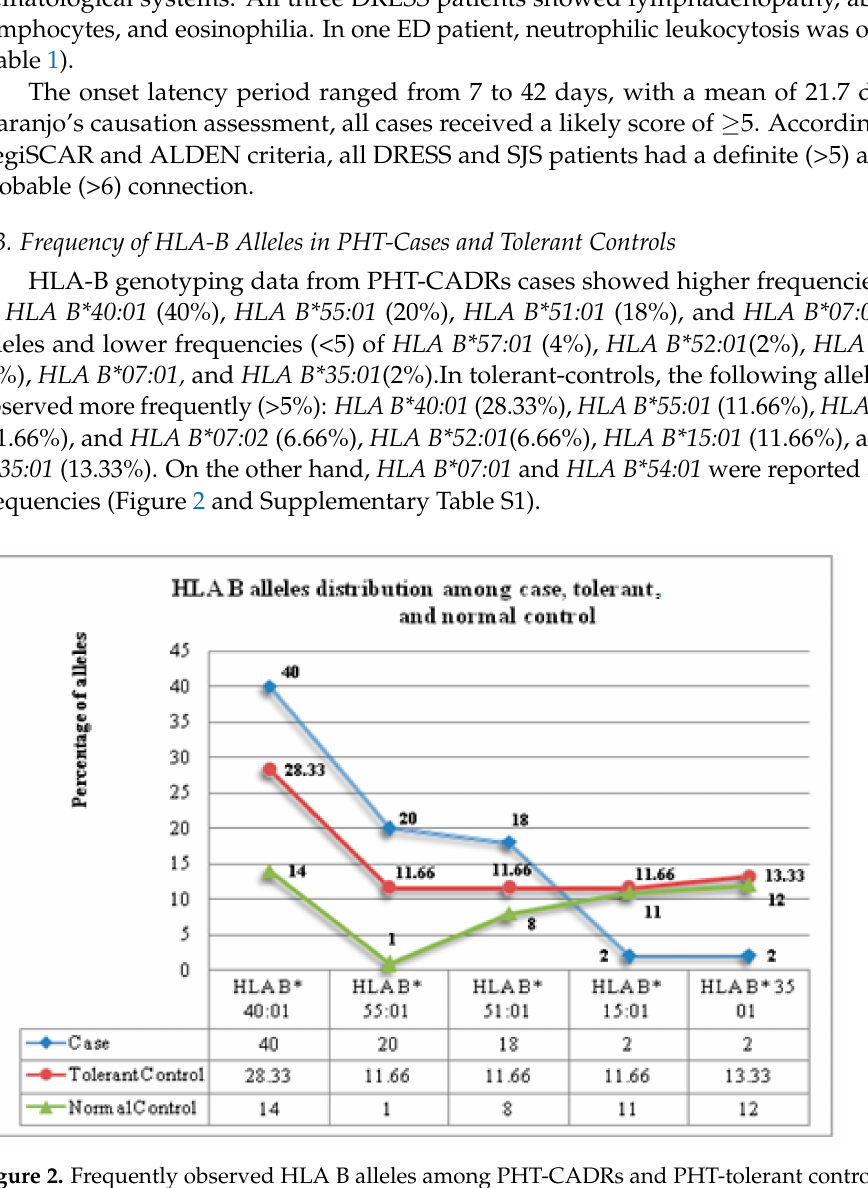
Figure 2. Frequently observed HLA B alleles among PHT-CADRs and PHT-tolerant